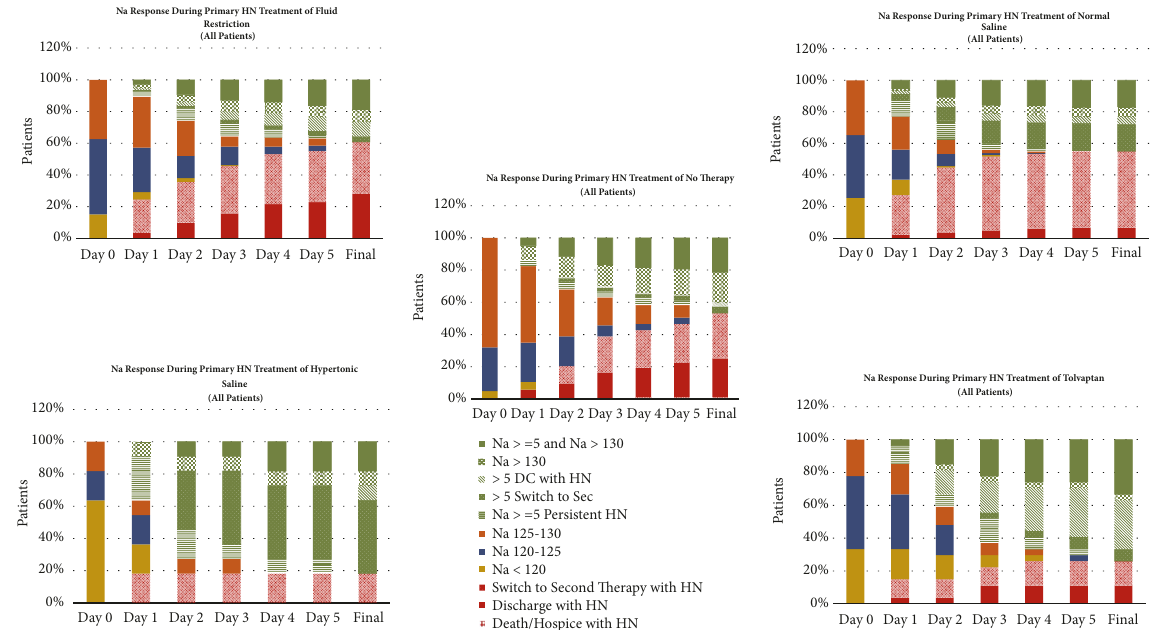
Figure 1: Response to primary hyponatremia (HN) treatment by various HN categories. [Na + ], sodium concentration; FR, fluid restriction; NS, isotonic saline; NST, no specified therapy; HS, hypertonic saline; TO, tolvaptan; DC, discontinuation.